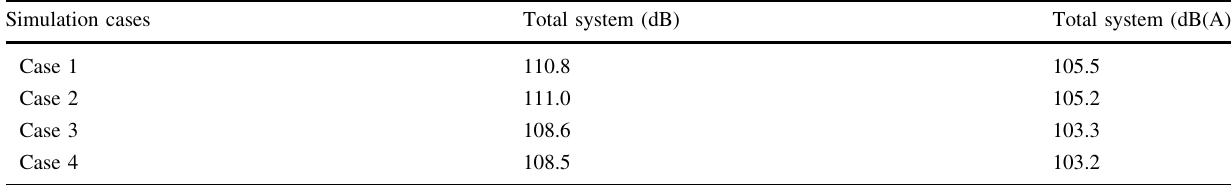
cavity is approximately 1 dB lower than for the baseline at the side receiver, whereas the noise radiated from the fol- ded pantograph increases by 7.5 dB compared with the baseline case. However, its contribution to the total noise is still negligible. Furthermore, the noise radiated from only the cavity itself is significantly reduced. For the noise generated by the whole system, two (one raised and one folded) pantographs and the cavity, when the cavity edges are rounded with radius h = D ¼ 0 : 8, a total reduction of 0.5 dB at the side and 1.7 dB at the top are achieved.